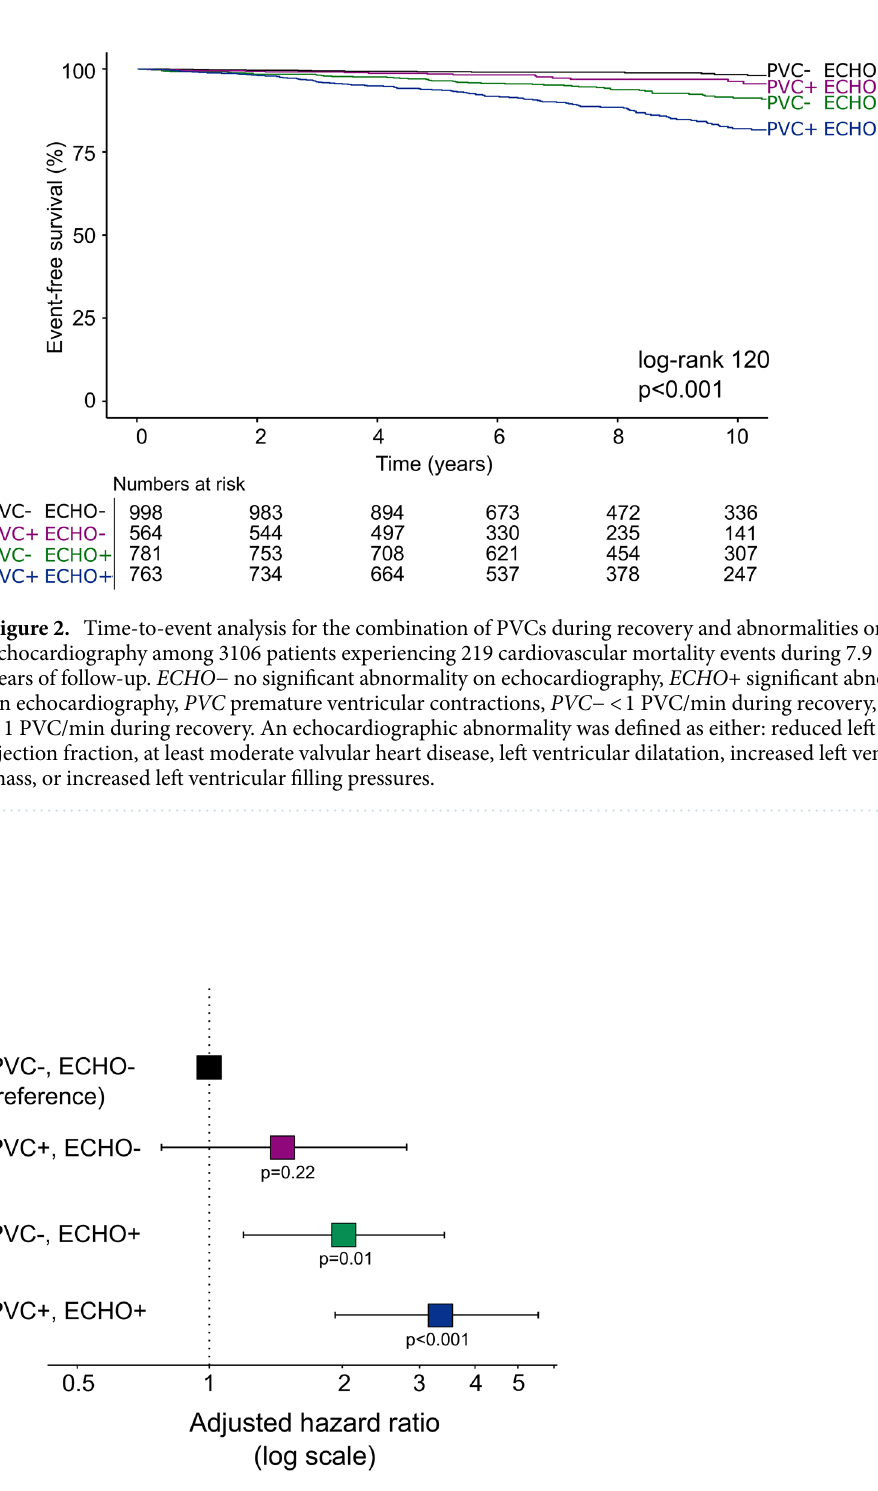
Figure 3. Forest plot showing hazard ratios for cardiovascular death with 95% confidence limits (adjusted for age, sex, hypertension, heart failure, ischemic heart disease, diabetes mellitus, body mass index, peak workload, maximal heart rate, maximal systolic blood pressure, heart rate recovery, ST depression, and cardiovascular medications) based on combinations of presence/absence of PVC during recovery and echocardiographic abnormalities. ECHO− no significant abnormality on echocardiography, ECHO+ significant abnormality on echocardiography, PVC premature ventricular contractions, PVC− < 1 PVC/min during recovery, PVC+ ≥ 1 PVC/min during recovery. An echocardiographic abnormality was defined as either: reduced left ventricular ejection fraction, at least moderate valvular heart disease, left ventricular dilatation, increased left ventricular mass or increased filling pressures defined as E/e ′ ≥ 15 and either dilated LA or increased RV–RA pressure